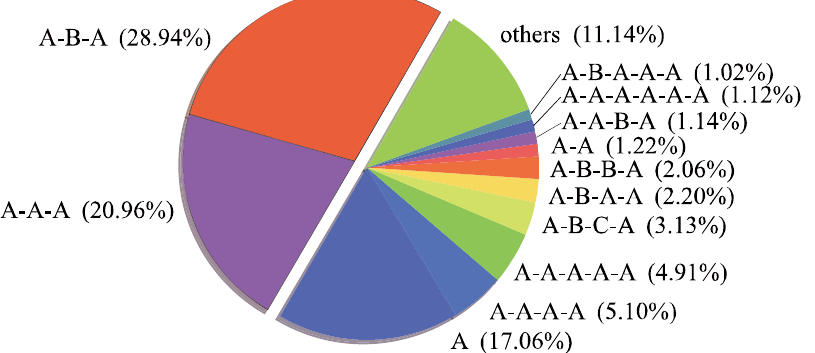
Figure 10. Proportions of mobility types.